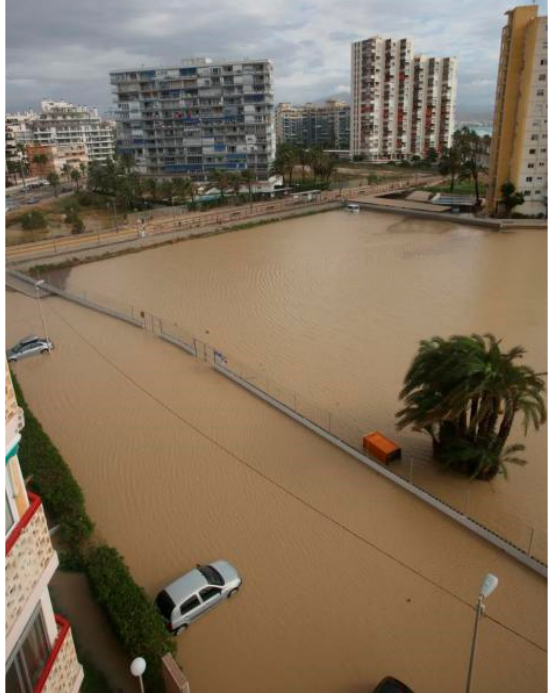
Figure 9. Old floodable area in San Juan Beach that has been urbanised since the 1960s. Note: episode of the 21 of August 2019. Source: [63]. Water 2020 , 12 , x FOR PEER REVIEW